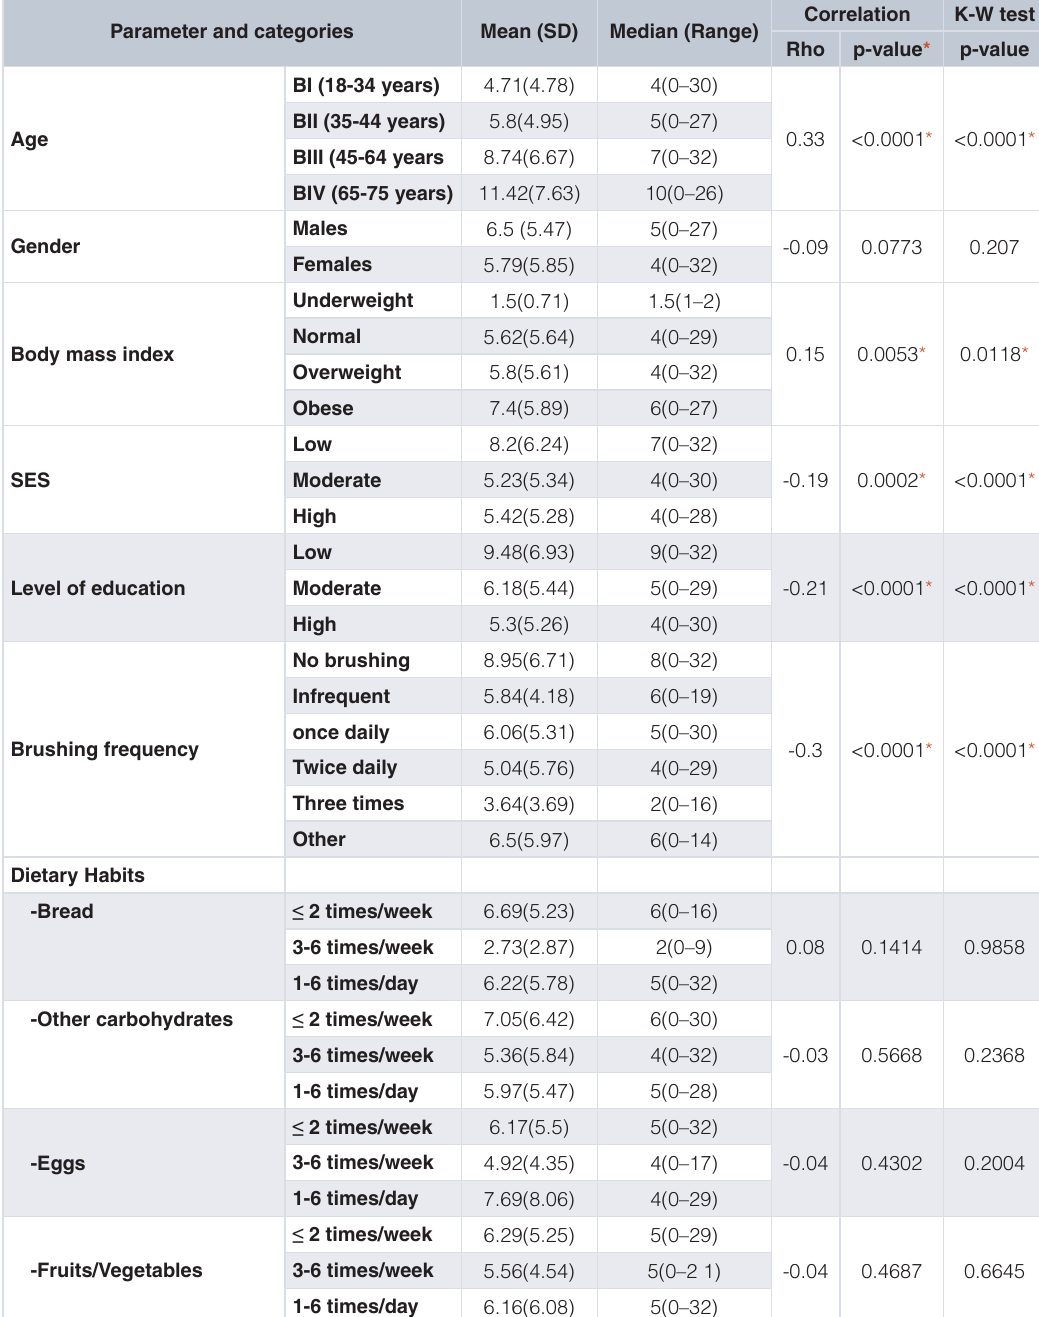
Table 6. DMFT and different risk factors (N=